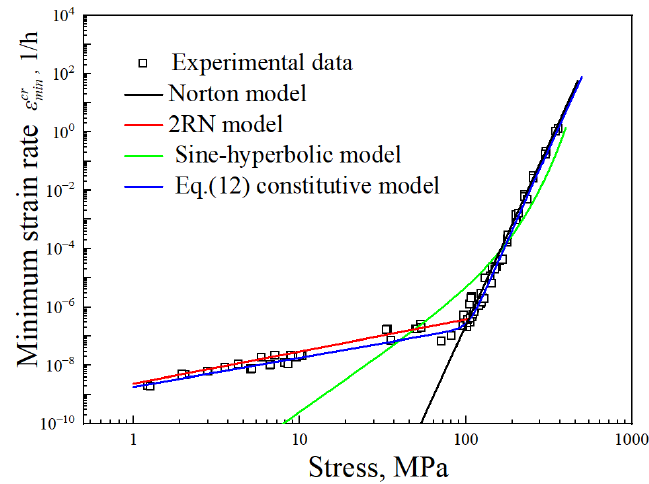
Figure 9. Creep strain rate vs. stress of the P91 steel at 600 ◦ C [34–37]. Due to the parameter in the Norton model obtained in the HS region, the model as the single-regime constitutive model can well characterize the creep strain rate in the HS region but not in the LS region. The 2RN model, as a stress-regime constitutive model, is fitted with different parameters in HS and LS regions and is in good agreement with the creep strain rate-stress data. However, the 2RN model is too dependent on the turning stress point (the point between the LS and HS regions) and the improper turning stress of the materials will provide the inaccurate creep strain rate prediction results in the transi- tion region [13,14]. For the sine-hyperbolic creep constitutive model, the parameter is ob- tained by fitting the available creep strain rate-stress experimental data from a uniaxial creep experiment. It is in good agreement with the experimental data in the HS region but not with the experimental data in the transition and LS regions. The Equation (12) consti- tutive model, based on the deformation mechanism, overcomes the shortcomings of the above models and fits well with the experimental data. This shows that the creep defor- mation of the materials can be accurately calculated by Equation (12) in a region with a wide range of stress levels. Table 2. Parameters in the constitutive models. Model